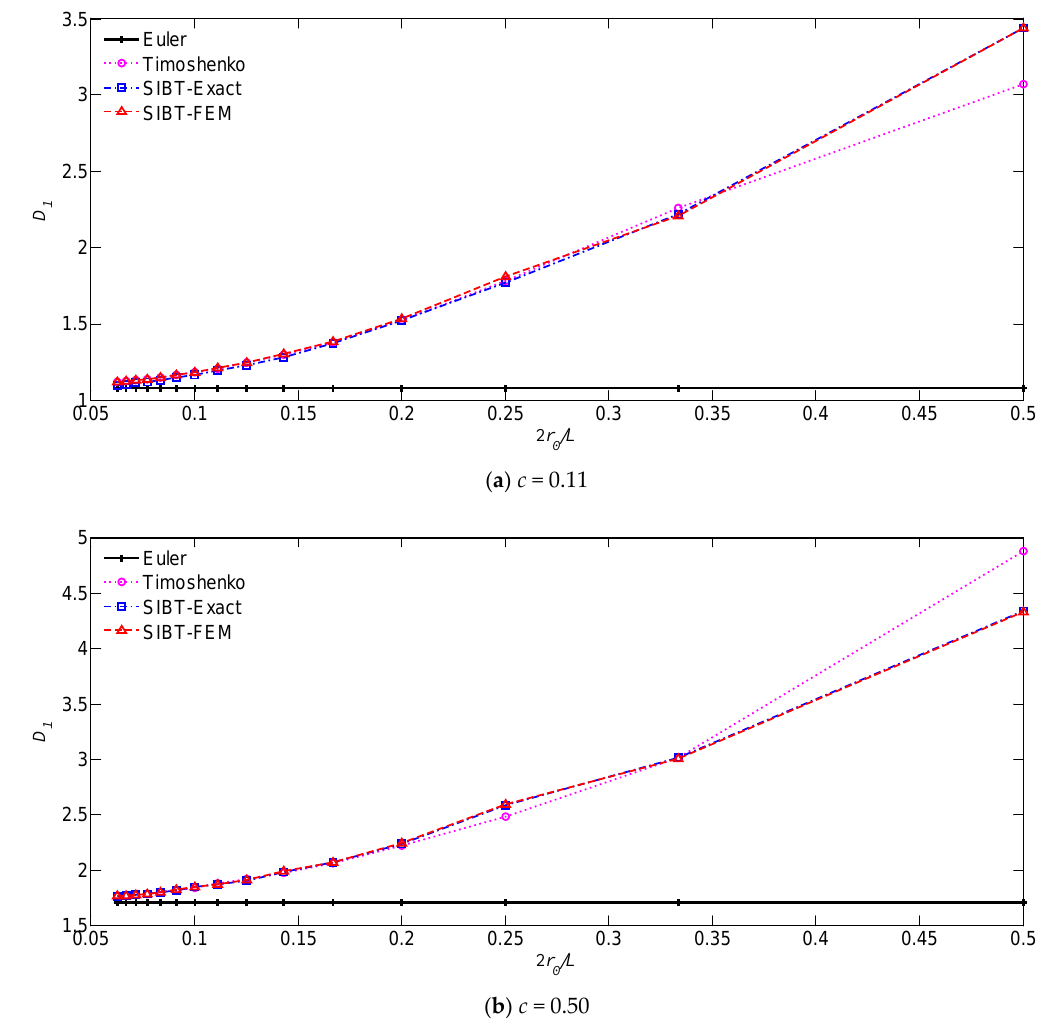
Figure 12. Dynamic magnification factors of the beam with different slenderness ratios.